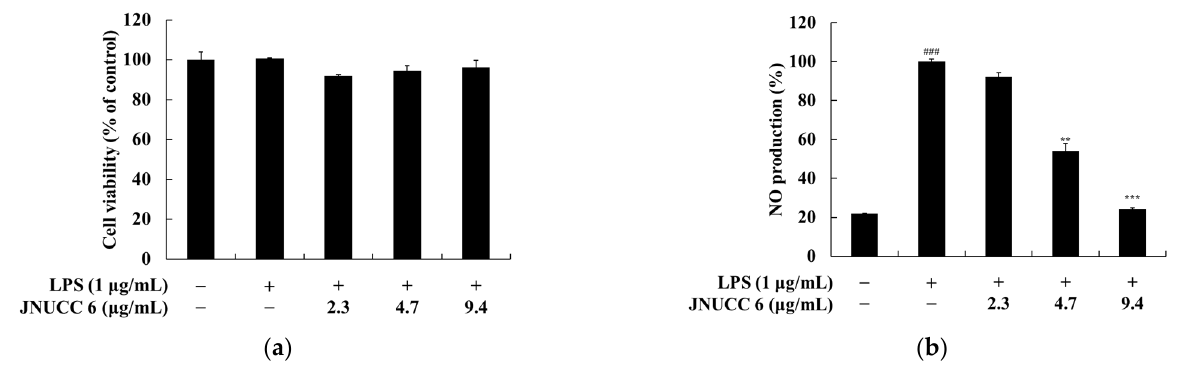
Figure 2. Inhibition of nitric oxide (NO) production by JNUCC6 extracts in RAW 264.7 cells. ( a ) Cell viability of JNUCC6/treated RAW 264.7 cells determined by MTT assay and represented compared to the non-treated group as percentage values. The cells (1.5 × 10 5 cells/well) were seeded for 24 h, and then in the presence of lipopolysaccharide (LPS), they were treated with varying concentrations of JNUCC6 extracts (2.3, 4.7, and 9.4 µg/mL) for 24 h. ( b ) The supernatant of the culture medium was collected and analyzed for NO using Griess reagent. The results are expressed as mean ± SD of data obtained from three independent experiments. ### p < 0.001 compared with control group; *** p < 0.001 and ** p < 0.01 compared with LPS-treated group.